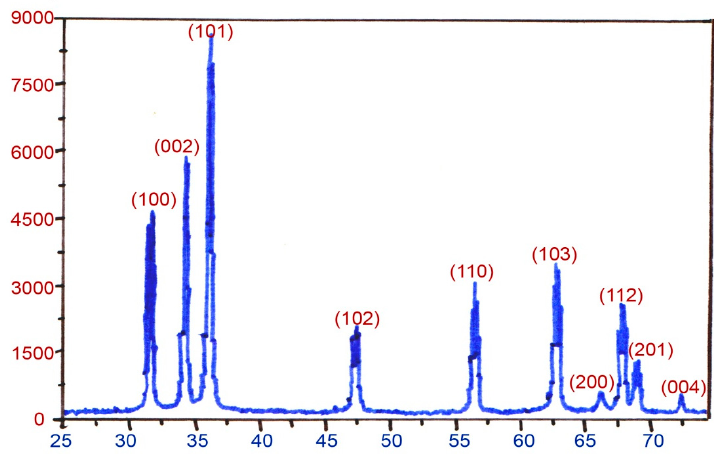
Figure 4. X-RD patterns of ZnO Figure 4. X ‐ RD patterns of ZnO Nanoparticles.